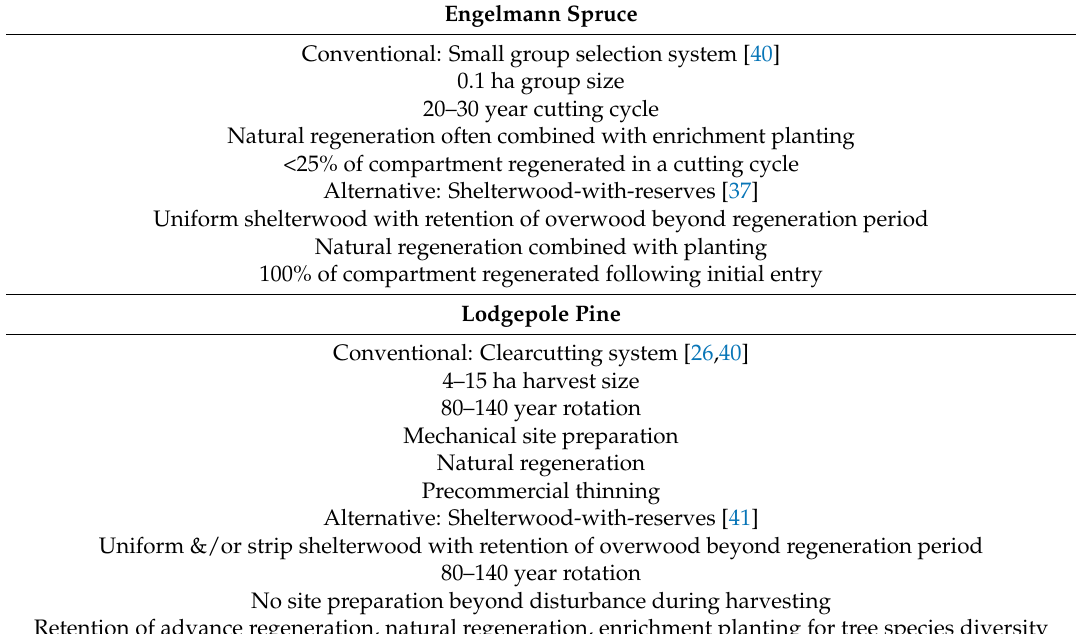
Table 4. Comparison of conventional and alternative silvicultural systems for Engelmann spruce and lodgepole pine in the Central